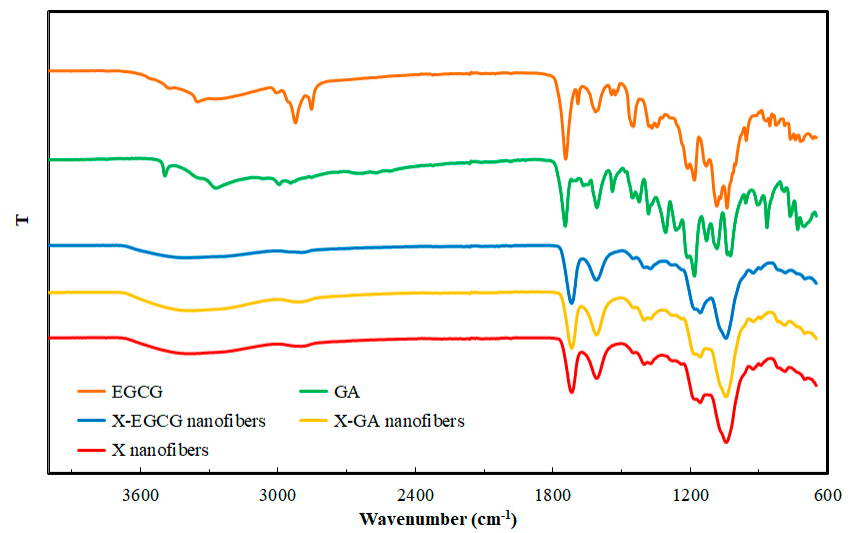
Figure 2. FTIR spectra of electrospun X, X-GA, X-EGCG nanofibers, GA, and EGCG.